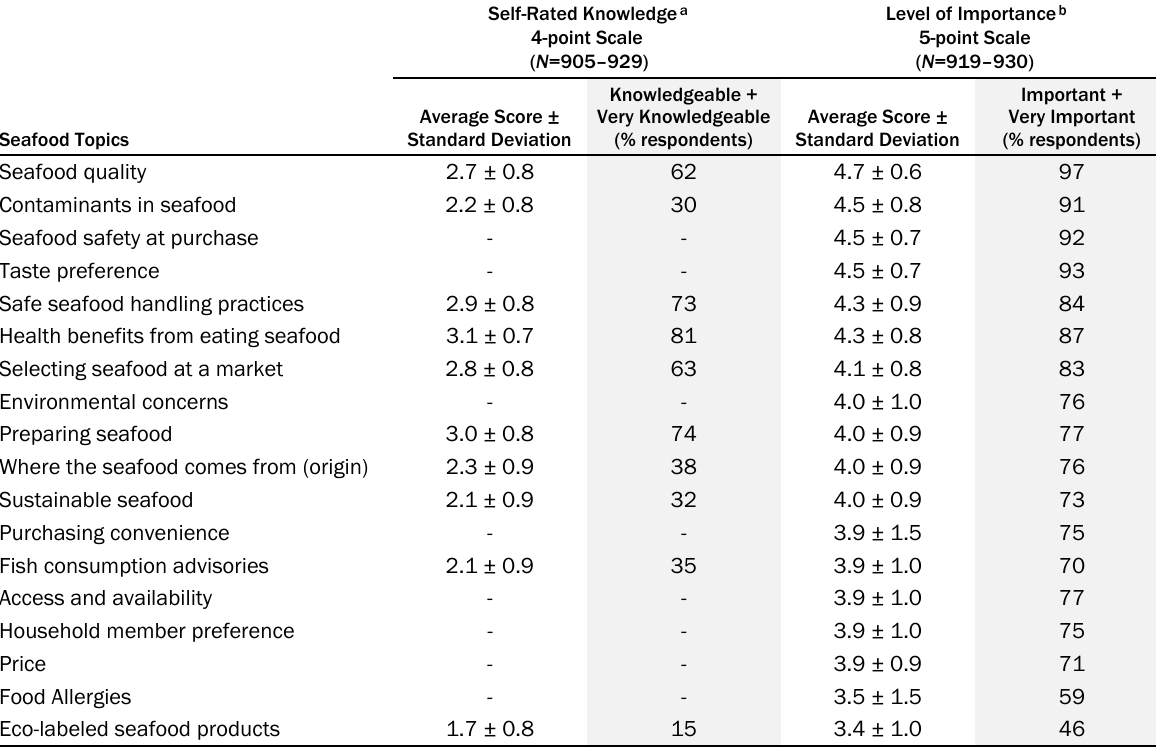
Table 5. Self-rated Knowledge with Level of Importance on Purchasing Habits of Seafood Topics among Rhode Island Consumer